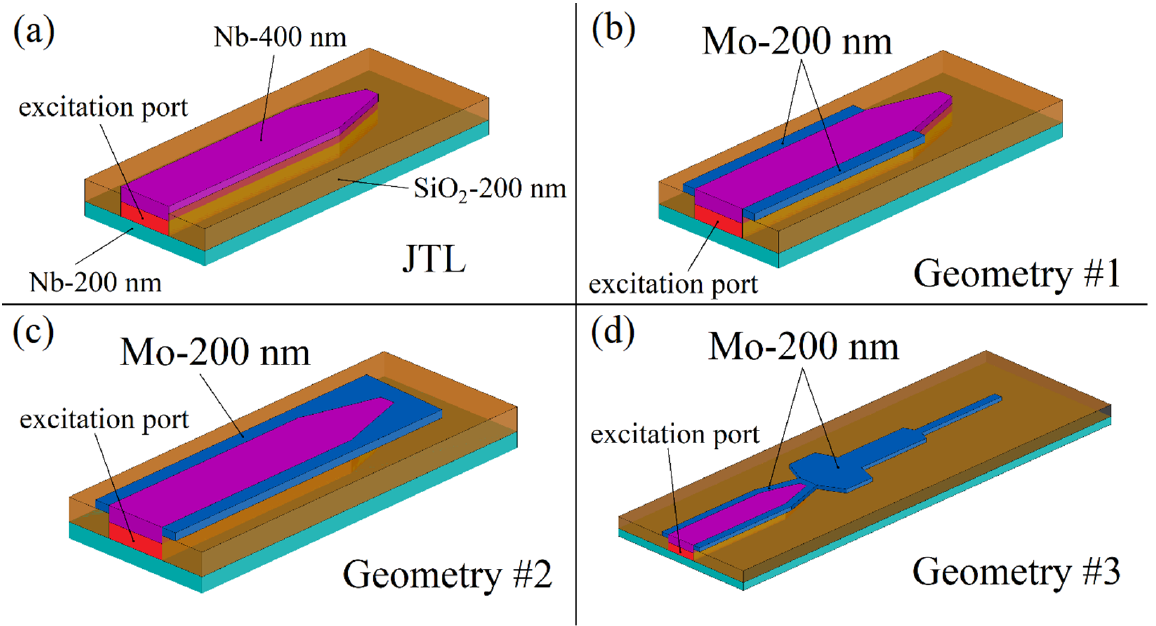
Figure 6. 3D-models of the simulated geometries. ( a ) FFO without idle region (geometry #0, corresponds to Figure 3a); ( b ) geometry with normal metal layer along the FFO where width is constant (geometry #1, Figure 3b); ( c ) circuit with normal metal layer at the end and along the junction (#2, Figure 3d); ( d ) design with the impedance transformer connected to the end (#3) in order to decrease the reflection.